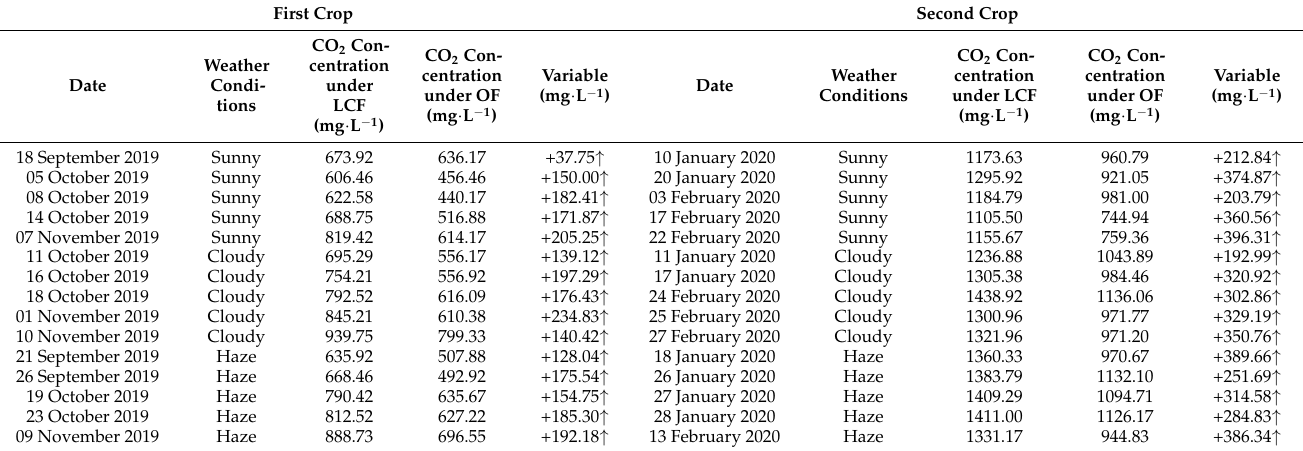
Table 3. Analysis of the effect of different weather on CO 2 concentration in light conversion film (LCF) and ordinary film (OF) greenhouse under different crops.